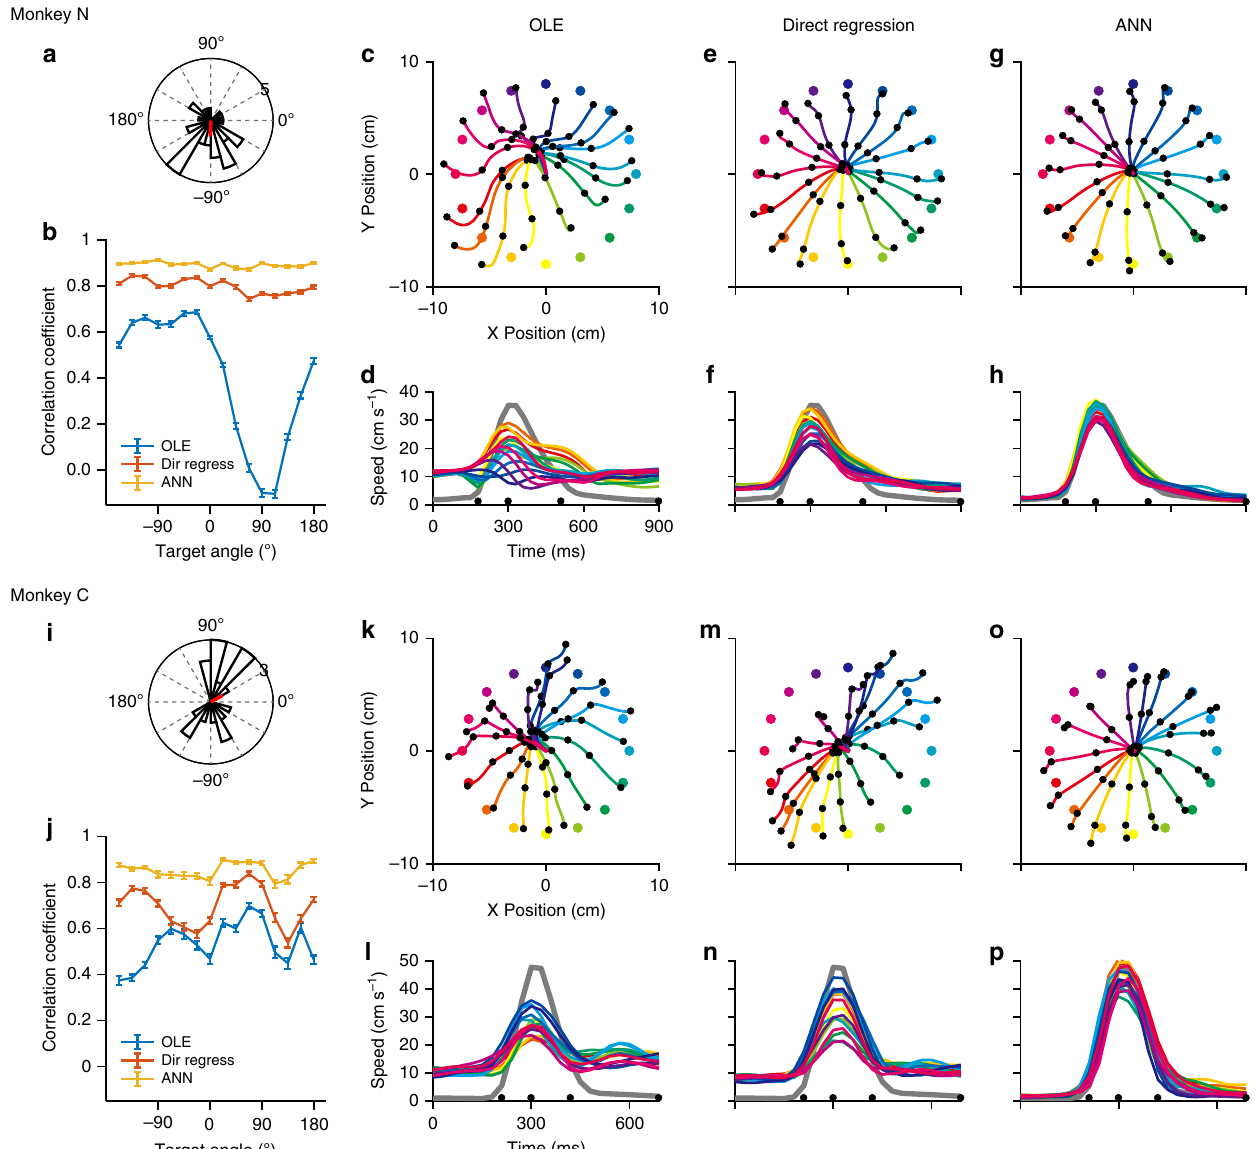
Fig. 7 Comparisons of performance between minimal OLE, Direct Regression and ANN using arm movement datasets. a , i Distribution of preferred directions for the selected 33 units for Monkey N and for 19 units of Monkey C. The red line represents the mean of each distribution . c , k Reconstructed trajectories using minimal OLE for monkeys N and C. d , l Speed pro fi les using minimal OLE for each monkey. e , m Reconstructed trajectories using Direct Regression. f , n Speed pro fi les using Direct Regression. g , o Reconstructed trajectories using the ANN for each monkey. h , p ANN Speed pro fi les. b , j Velocity correlation coef fi cients between decoded and actual data for all trajectories of monkeys N and C. The correlation coef fi cients from the ANN decoder were signi fi cantly higher than those of the OLE. ( p < 0.001, t -test, Bonferroni). Error bars denote the 95% con fi dence interval over all trials ( n = 69 × 10 trials per target for Monkey N and 47 × 10 trials for Monkey C from the 10 repetitions of cross-validation decoding analysis with random